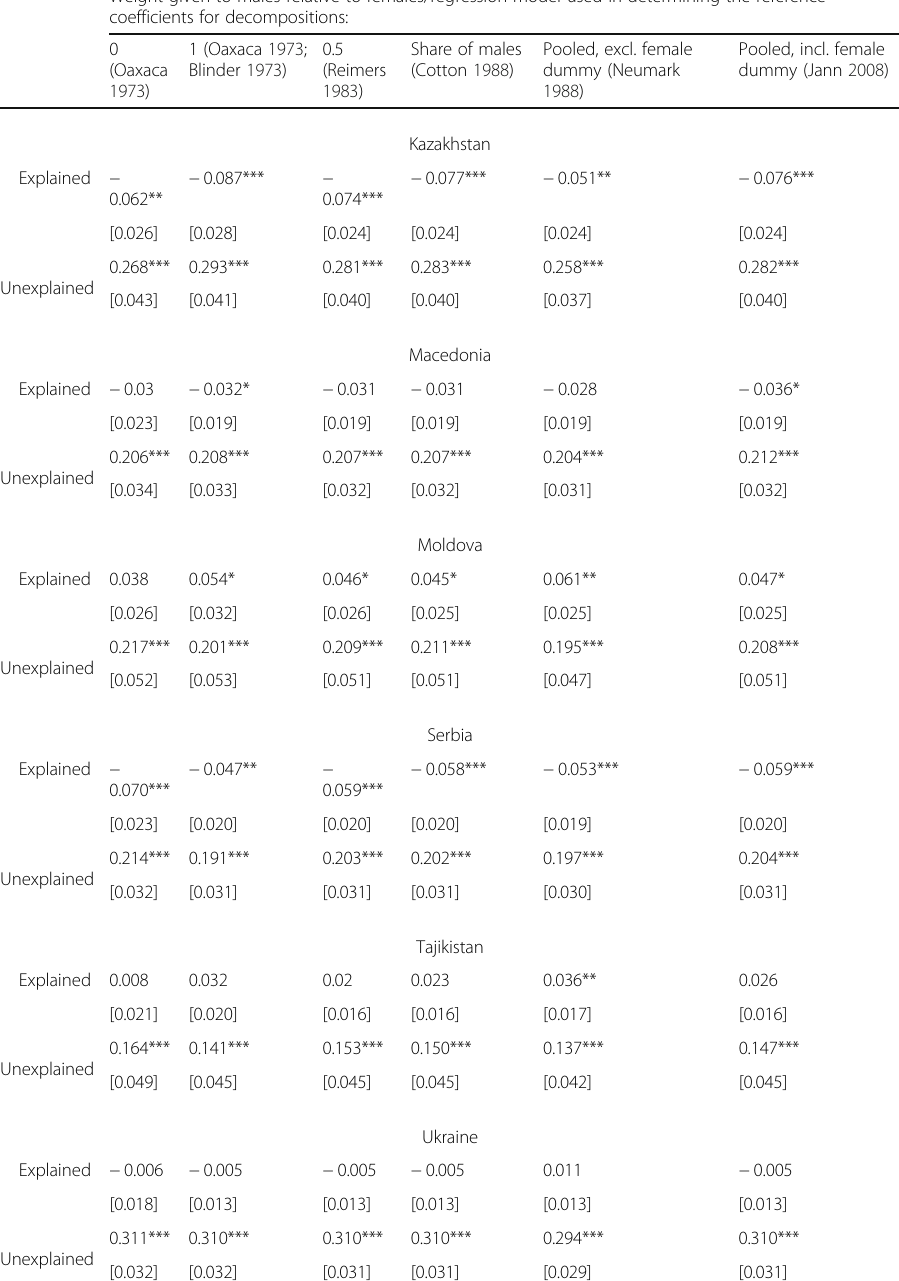
Table 13 Overall income decompositions, sensitivity analysis: twofold Weight given to males relative to females/regression model used in determining the reference coefficients for